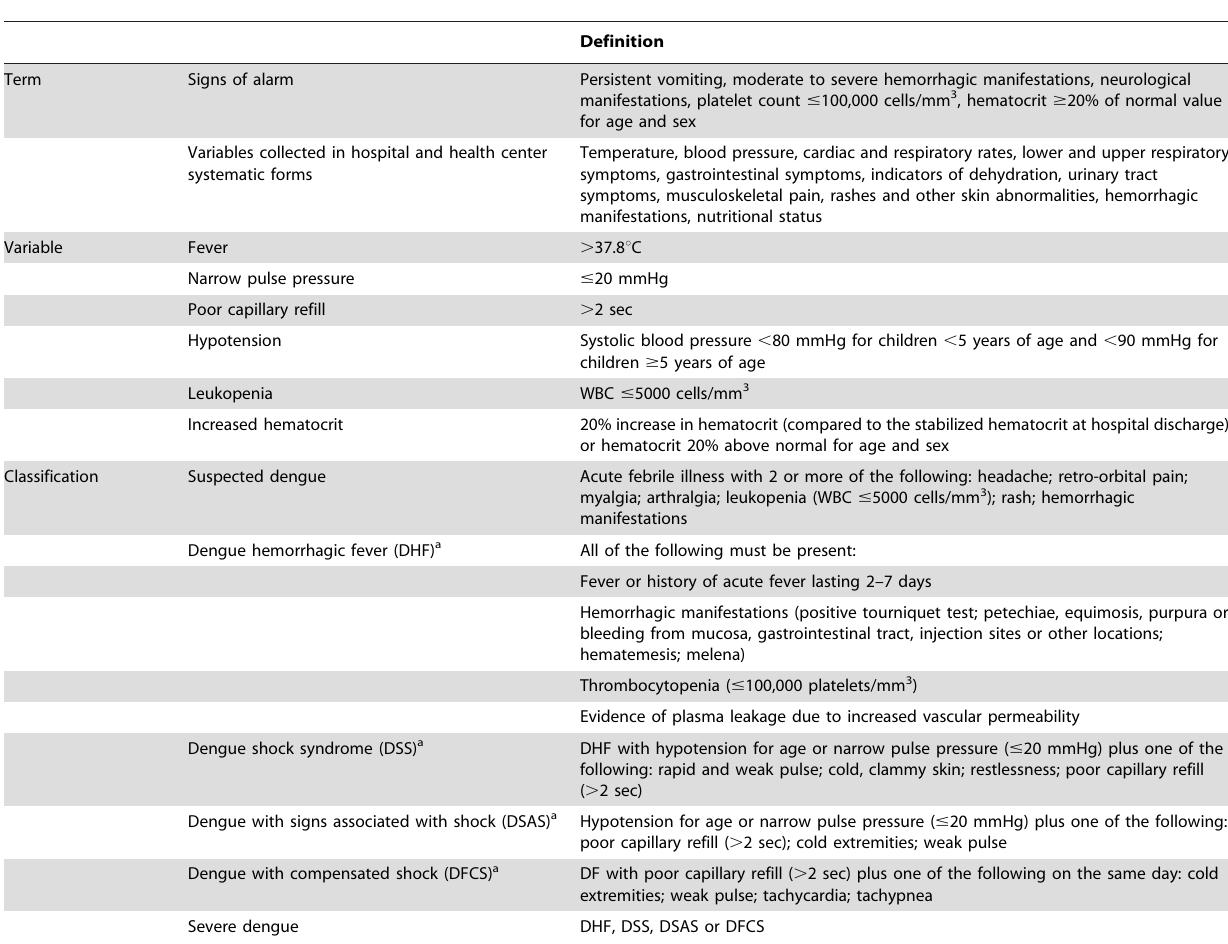
Table 1. Definitions of clinical terminology, variables and disease